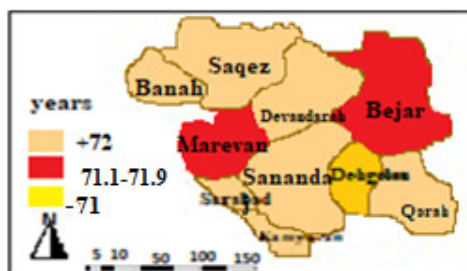
Figure 2. Life expectancy for women in rural areas of Kurdistan Province, 2013